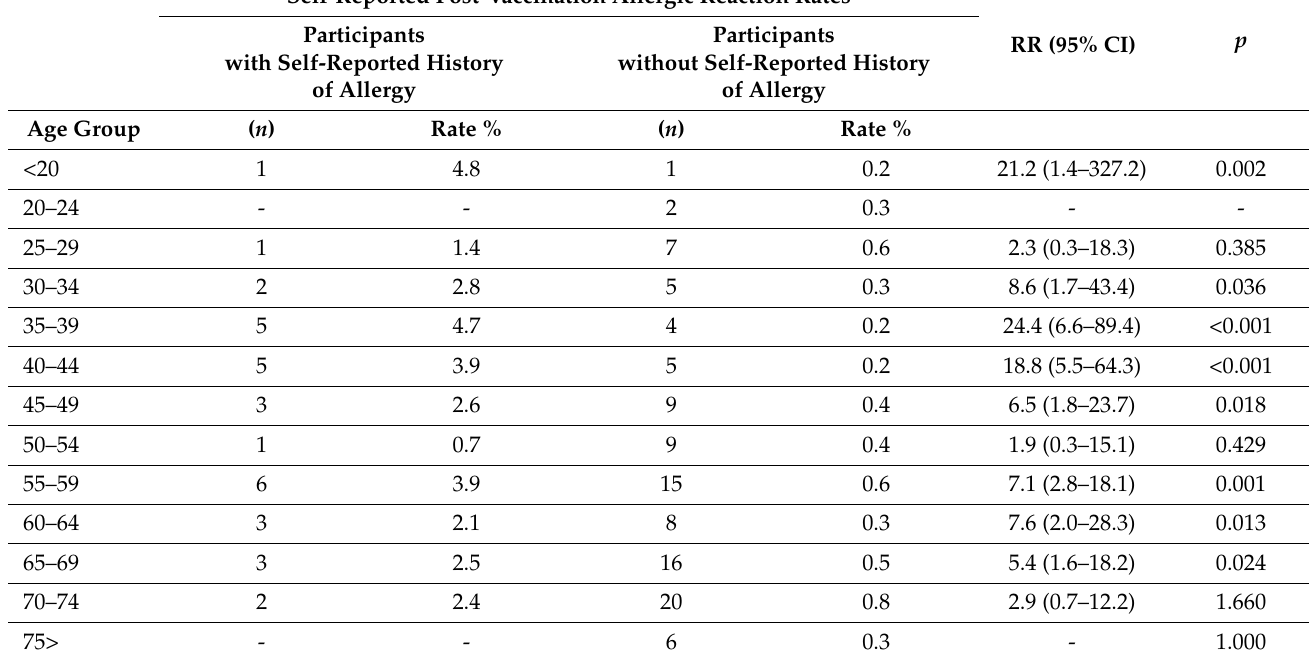
Table 5. Distribution of self-reported post-vaccination allergic reaction rates among participants with self-reported history of allergy, stratified by age